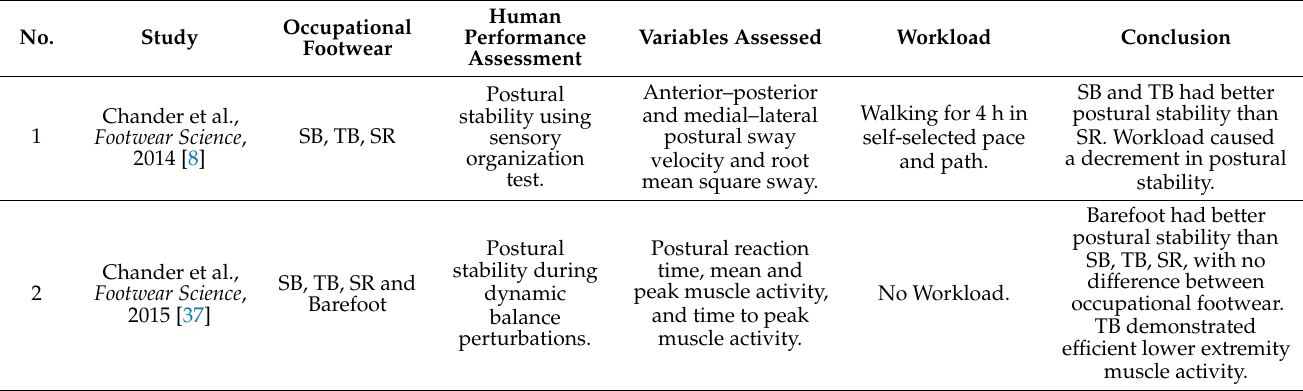
Table 2. Summary of occupational footwear